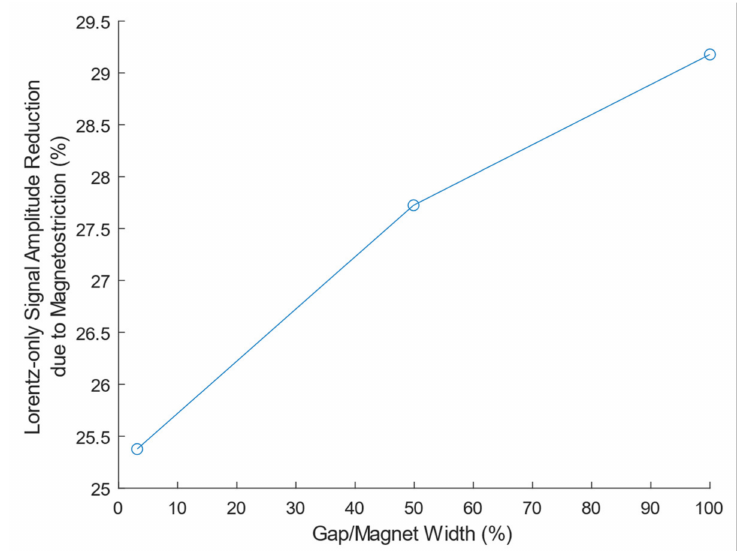
Figure 15. Reduction in the theoretical Lorentz-only PPM-to-PPM Maximum Receiver Voltage due to Magnetostriction vs. PPM EMAT Transmitter Gap/Magnet Width